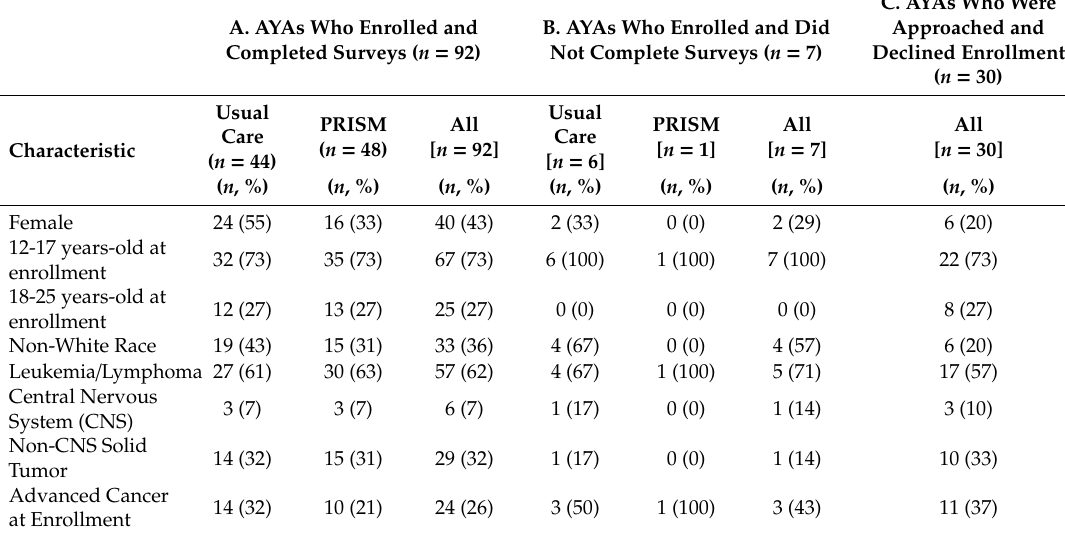
PRISM: Promoting Resilience in Stress